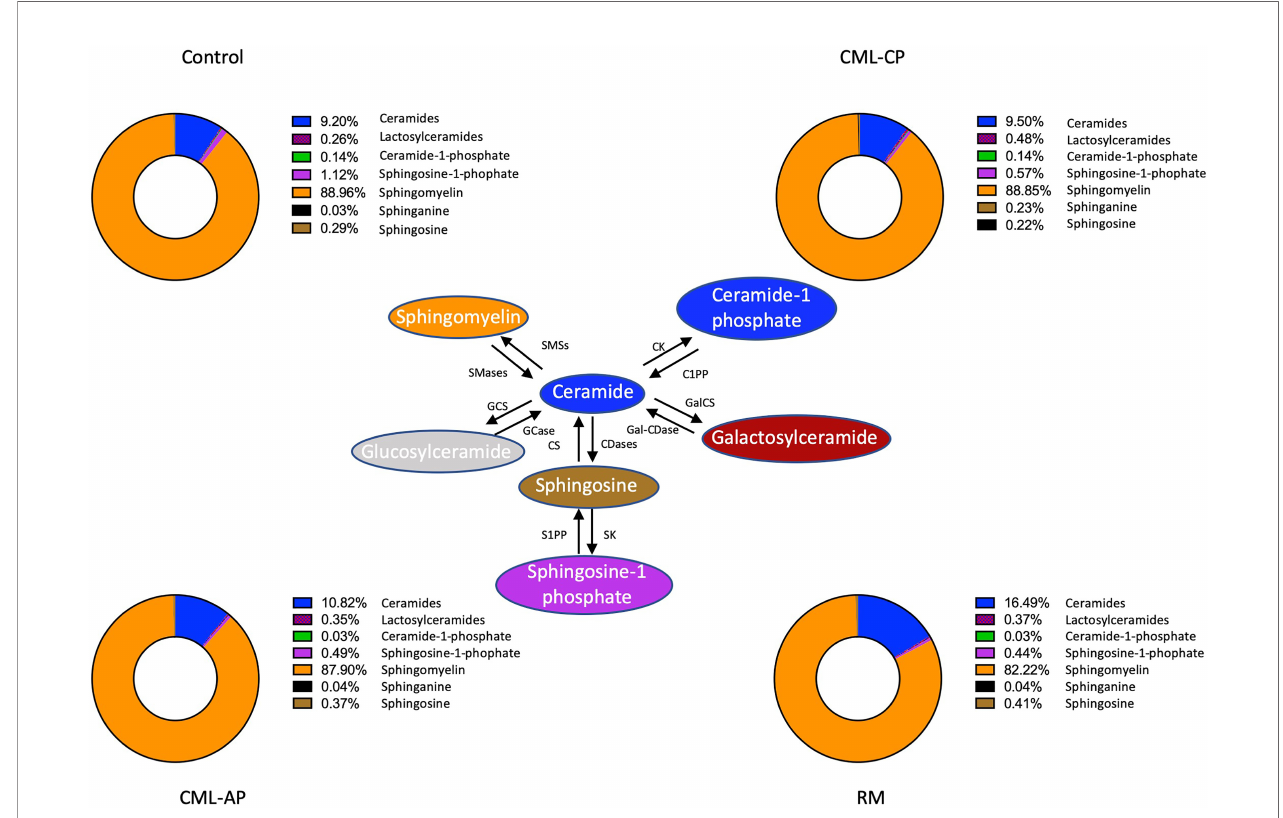
FIGURE 2 | Sphingolipid pro fi le in chronic myeloid leukemia patients. Relative frequency of sphingolipid classes in the control group and patients in the chronic (CP) and advanced (AP) phases of the disease and in remission post-TKI therapy (RM). SMSs, Sphingomyelin synthase; SMases, Sphingomyelinase; CK, ceramide kinase; C1PP, ceramide-1-phosphate phosphatase; GCS, glucosylceramide synthase; GCases, Glucocerebrosidase; CS, ceramide synthases; CDases, ceramidases; GalCS, galactosylceramide synthase; Gal-CDase, galactosylceramidase; SK, sphingosine kinase; S1PP, spingosine-1-phosphate